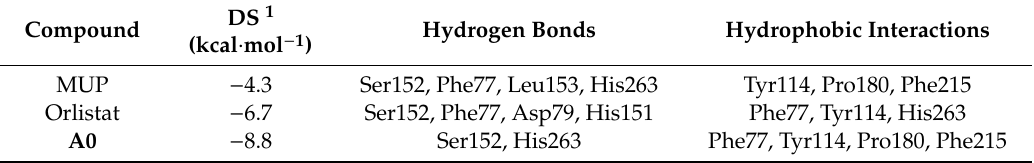
Table 1. Docking profiles of methoxy undecyl phosphonic acid (MUP), orlistat, and the general structure of aurones.